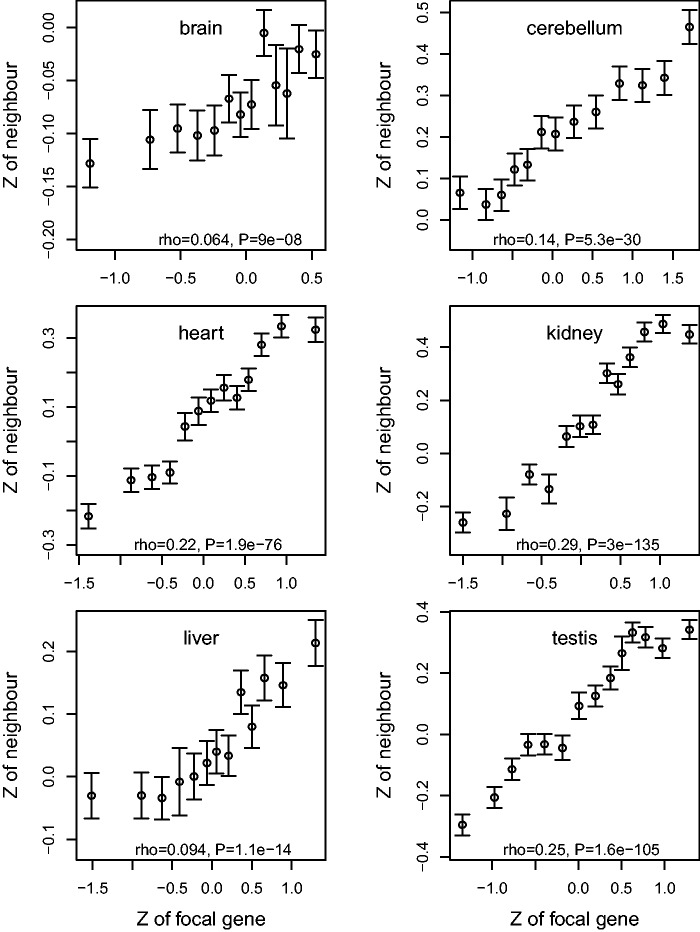
Relationship between Z of a focal gene and Z of the nearest downstream neighbor for six male tissues. In this instance we consider all genes are nearest downstream neighbors if the distance between the start codons is <100 kb. This slightly contrasts with data in table 1, where the distance is defined as minimum distance between gene bodies. Trends are robust to alternative definitions. Data are split into equal sized bins (of 500 genes) defined after rank ordering with respect to Z score of the focal gene. The value on the X axis represents the mean Z of the genes in that bin. The value of the Y axis indicates the mean (±SEM) for the relevant flanking genes. The presented statistics are from Spearman correlation on raw data.